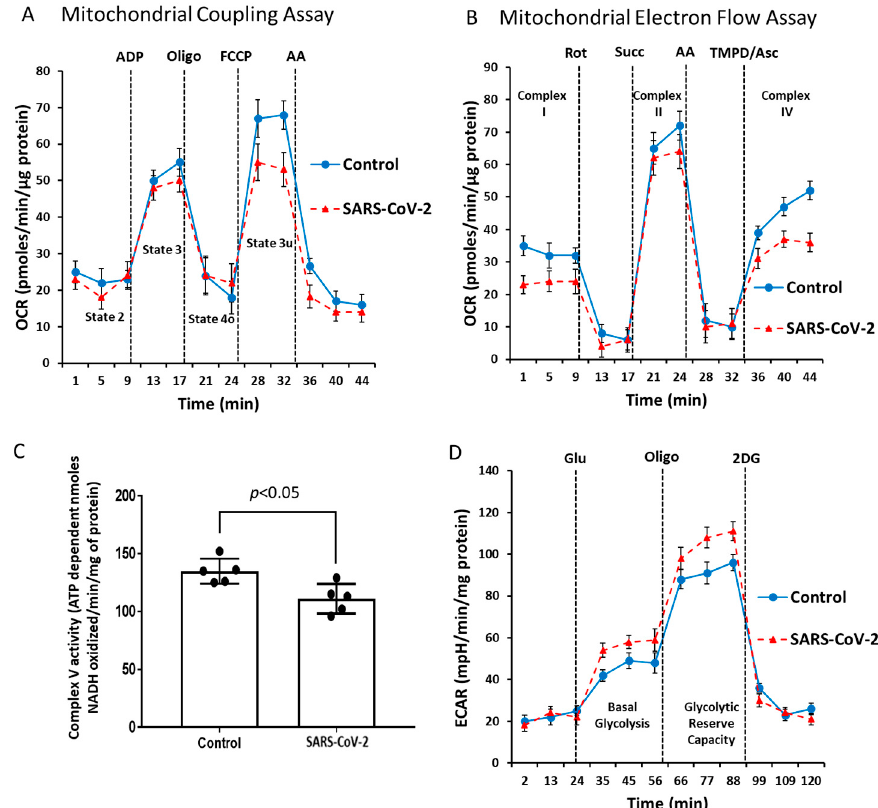
Figure 4. SARS-CoV-2 infection causes impairment of mitochondrial bioenergetics. Mitochondrial respiration/function was determined by oxygen consumption rate (OCR) measured by the Seahorse XF24 Extracellular Flux Analyzer (Seahorse Bioscience). ( A ) During the coupling experiment with isolated mitochondria, the assay media contains succinate as a complex II substrate and rotenone as a complex I inhibitor. Sequential measurement of basal, State 2, State 3, State 4o, and the uncoupler- stimulated respiration, State 3u, were performed through the sequential injections of ADP, oligomycin, FCCP, and antimycin. ( B ) An Electron-Flow assay demonstrates the electron flow activity through different complexes of the ETC. The assay media contains pyruvate/malate as substrates of complex I, and FCCP to uncouple the mitochondrial function. In uncoupled mitochondria all complexes were examined individually by the sequential injection of rotenone, succinate, antimycin, and TMPD/ascorbate to monitor the inhibition of complex I, activity of complex II, inhibition of complex II, and activity of complex IV, respectively. ( C ) Bar graph showing mitochondrial ATP synthase (complex V) activity. ( D ) A glycolytic activity profile was monitored by measuring ECAR using a Seahorse XF24 Extracellular Flux Analyzer. Basal glycolysis and glycolytic reserve capacity were measured by sequential addition of glucose, oligomycin, and 2-DG in lung tissue lysates. Values are means ± SD.